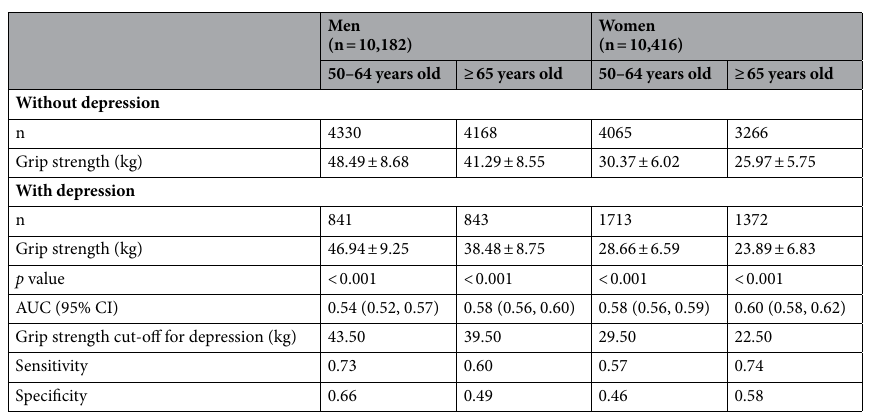
Table 2. Receiver operating characteristic for handgrip strength as an indicator of not having depression. AUC area under curve, CI confidence